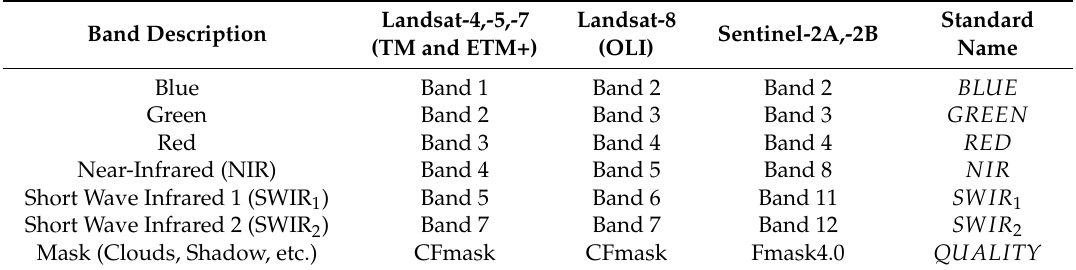
Table 1. Overview of used individual and standard band names.